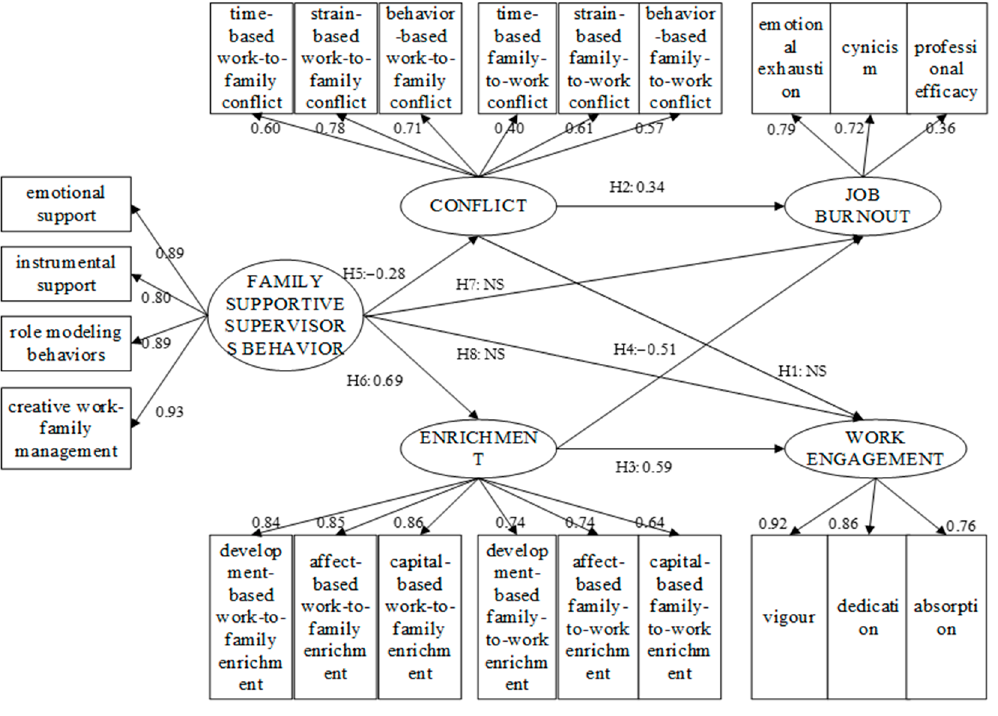
Figure 8. Final accepted model.